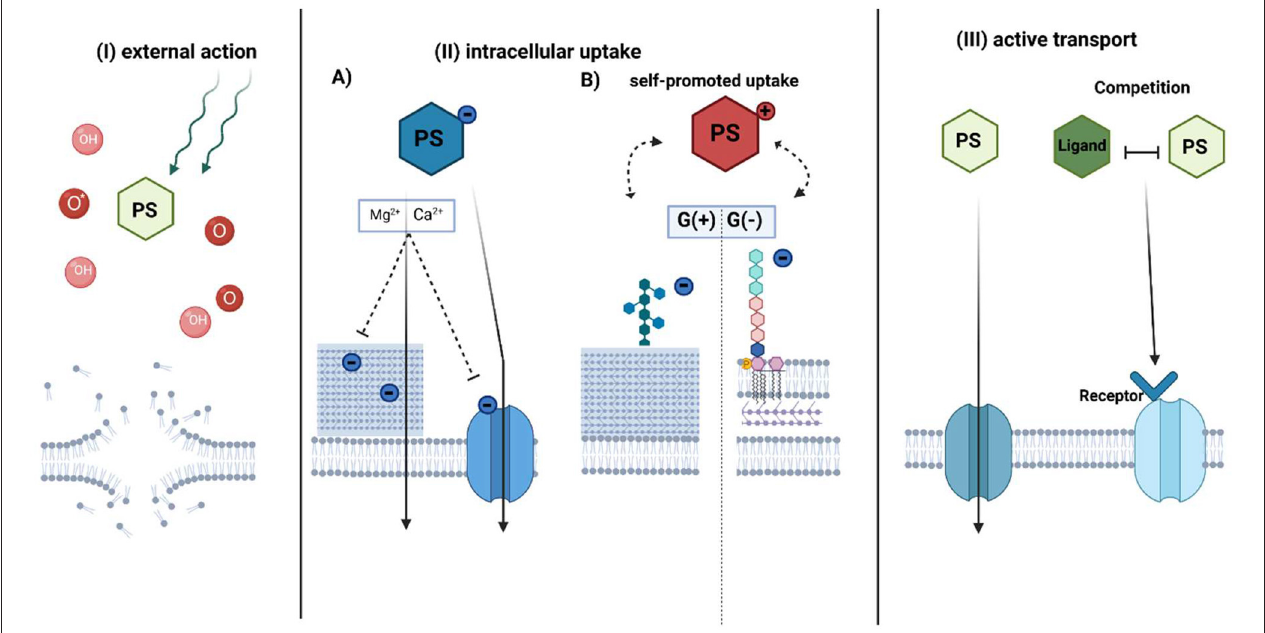
FIGURE 5 | Proposed mechanisms of photosensitizer accumulation in aPDI treatment. The photosensitizer uptake mechanism can be divided into three general pathways: (I) external action, (II) intracellular action, and III) active transport-dependent accumulation. In the external action (I) , PS does not accumulate inside the bacterial cell, however, due to the diffusion length of generated ROS (OH) or singlet oxygen (O * ) upon irradiation, it causes the membrane disruption. The intracellular action (II) depends on the PS charge. (A) Anionic PS is accumulated by electrostatic interactions or active transport. The addition of divalent cations neutralizes negative charge on the bacterial envelope and promotes uptake of negatively charged PS through membranes. (B) Cationic PSs use mechanism known as “self-promoted uptake.” The positively charged compound is bound to the negatively charged teichoic acids on the peptidoglycan of the G( + ) or lipopolysaccharides on the outer membrane of G(-) bacteria. The photosensitizer is associated with the surface layer, while after photosensitization it promotes cell disruption. In active transport (III) , PS is taken up inward through a membrane protein channel such as porins or by mimicking receptor binding due to structure similarity to its natural ligand. PS-photosensitizer, O * - singlet oxygen, OH- radicals referred in general as ROS. (Created with